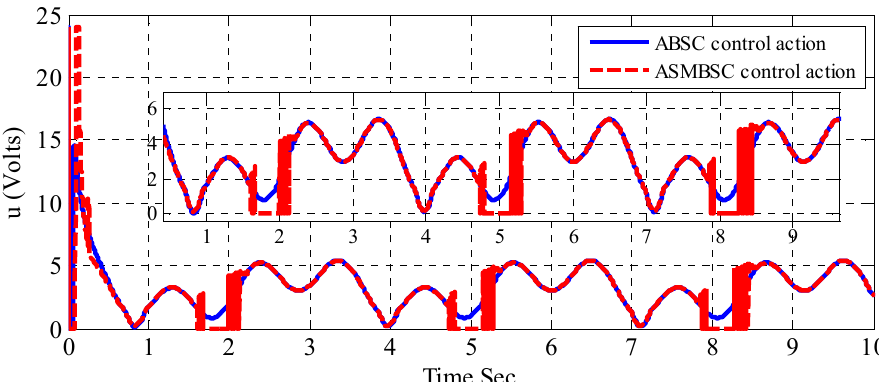
Figure 7. Plate angular speed response based on adaptive backstepping and adaptive sliding mode backstepping controllers.